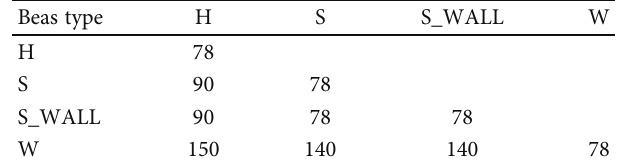
Figure 2: Sketch of fl ow model. Table 2: The conservative